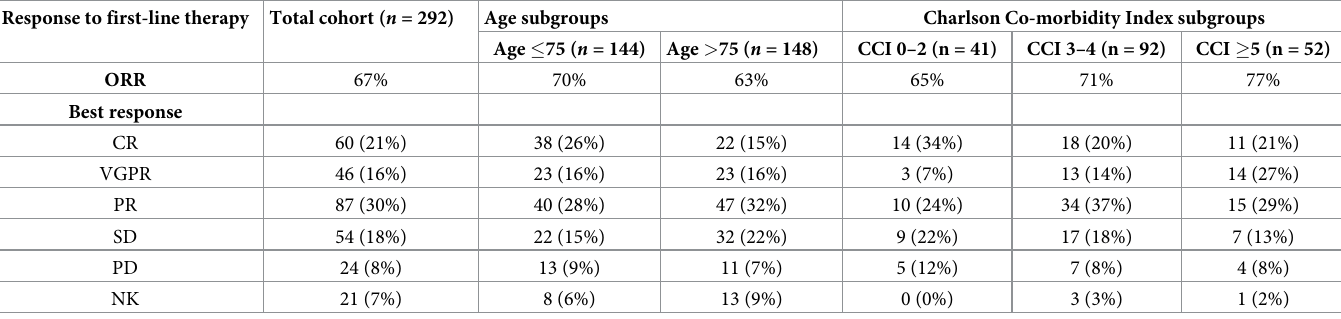
Table 4. Response rates to first line